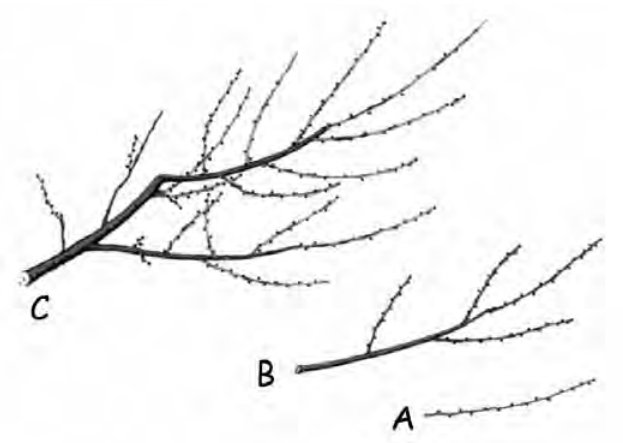
Fig. 3 - Evolution of a one-year axis (A) into two-year (B) and three- year (C) branches.